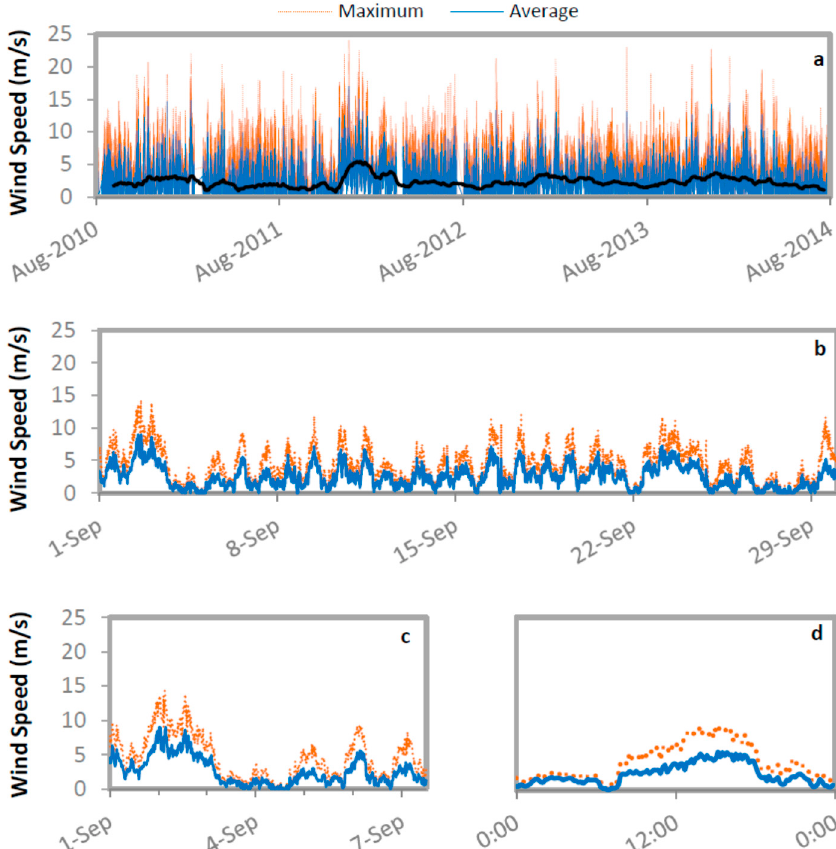
Figure 2. Wind speed time series at the research facility in Langenreichenbach, Germany at different time scales: ( a ) Period of record; ( b ) monthly (September 2013); ( c ) weekly (1–7 September 2013); and ( d ) daily (5 September 2013).